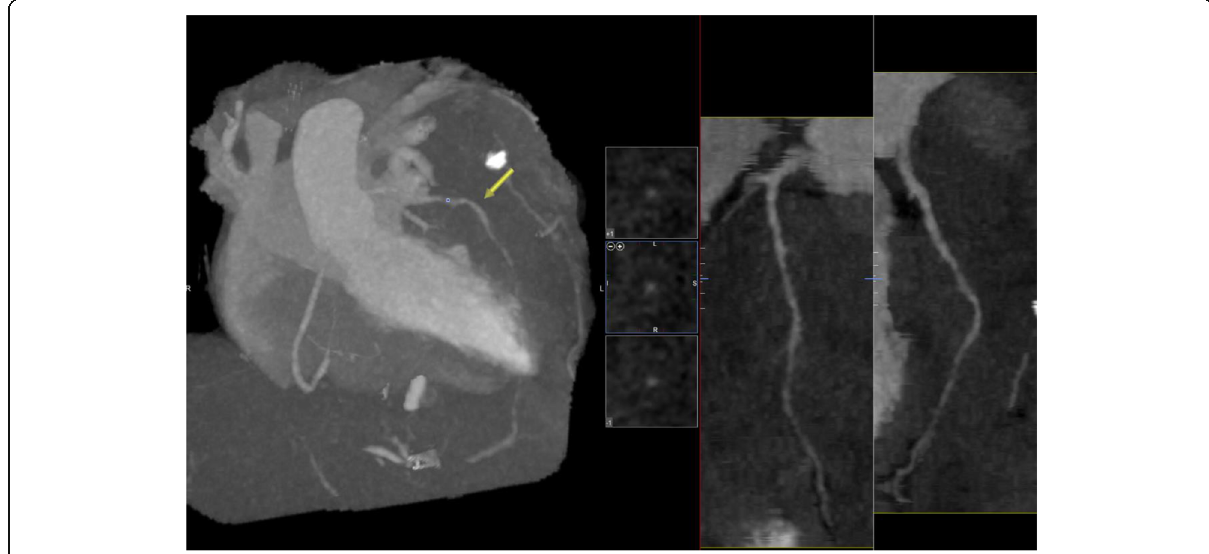
Fig. 4 CT coronary angiogram reveals displacement of the left anterior descending coronary artery (LAD) yellow arrow. Right anterior oblique